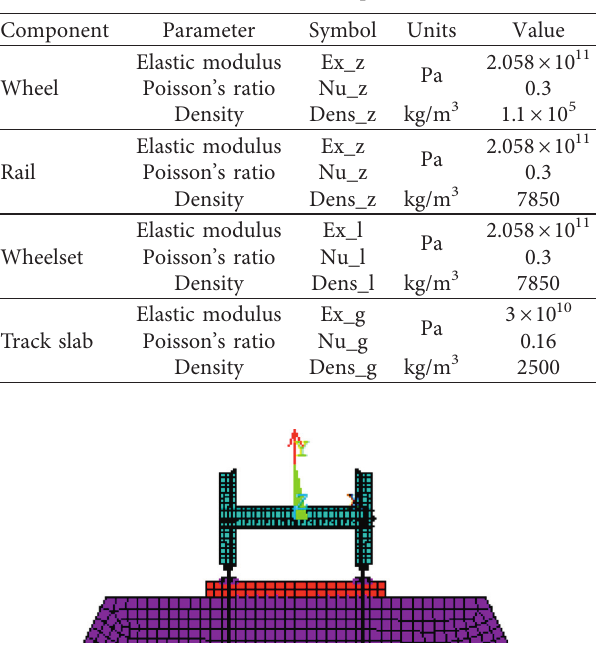
Table 1: Model material